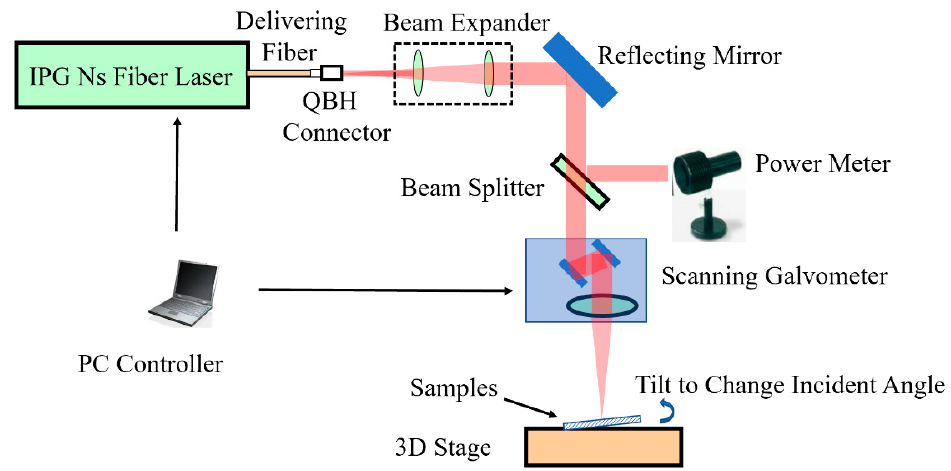
Figure 2. A schematic of the experimental setup. With a PC controller, the output laser beam and the action of the scanning galvanometer could be well synchronized. By raising one side of the samples and then measuring with a level meter, the incident angle could be tuned. Table 1. Laser parameters for the study of the laser light incident angle’s influence.